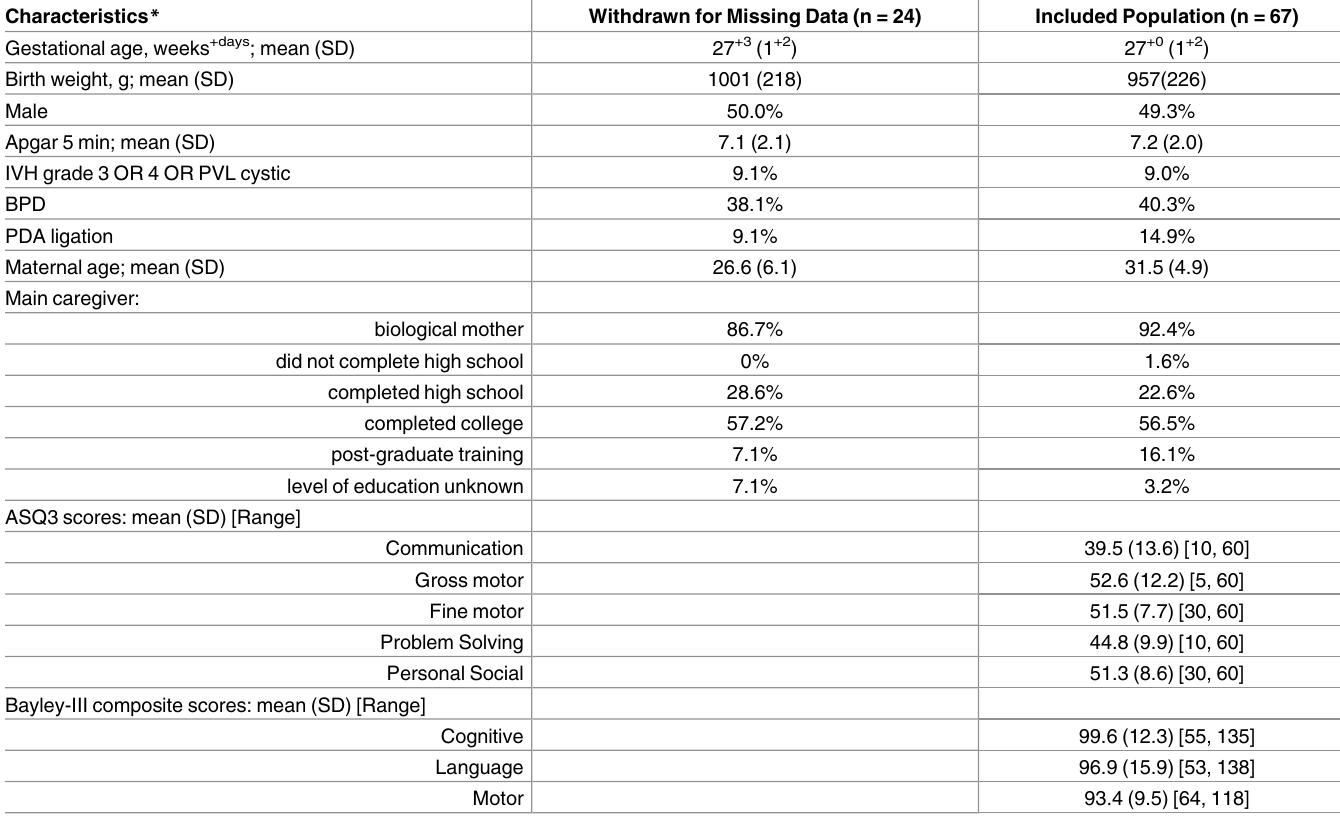
Table 1. Demographic characteristics.